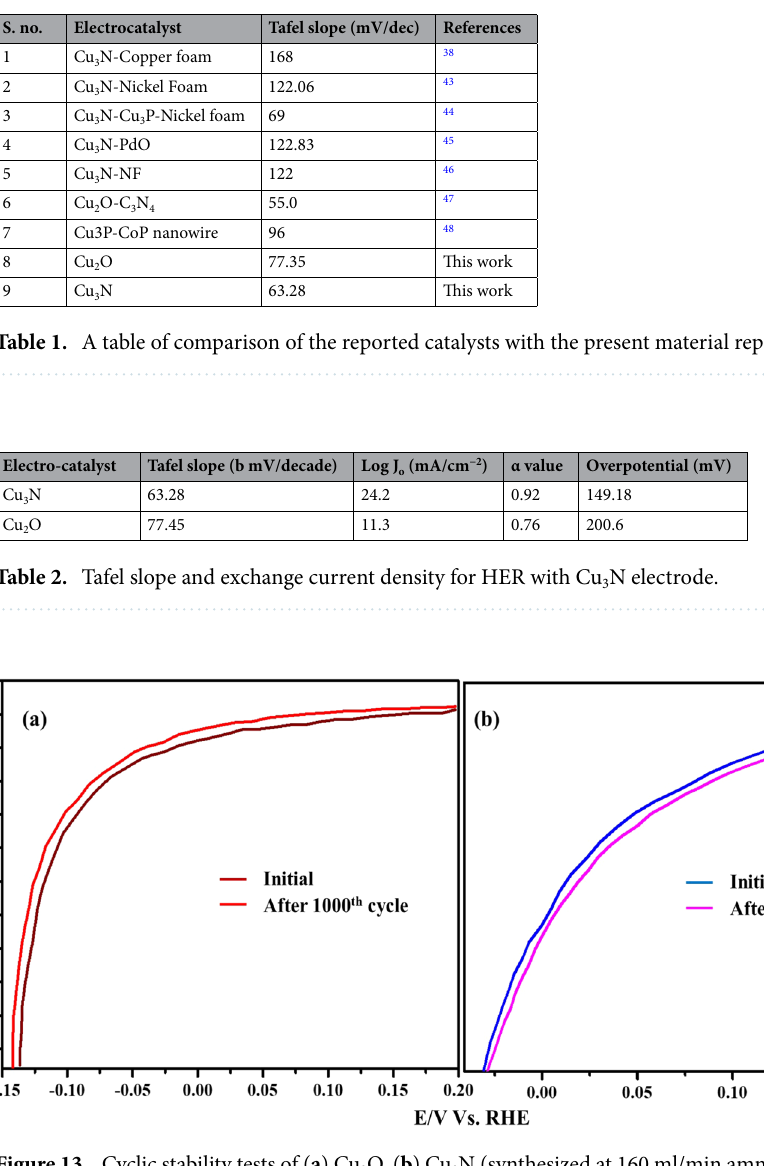
Figure 13. Cyclic stability tests of ( a ) Cu 2 O, ( b ) Cu 3 N (synthesized at 160 ml/min ammonia flow rate and 300 °C) tested using cyclic voltammetry at a scan rate of 2 mV/s vs.